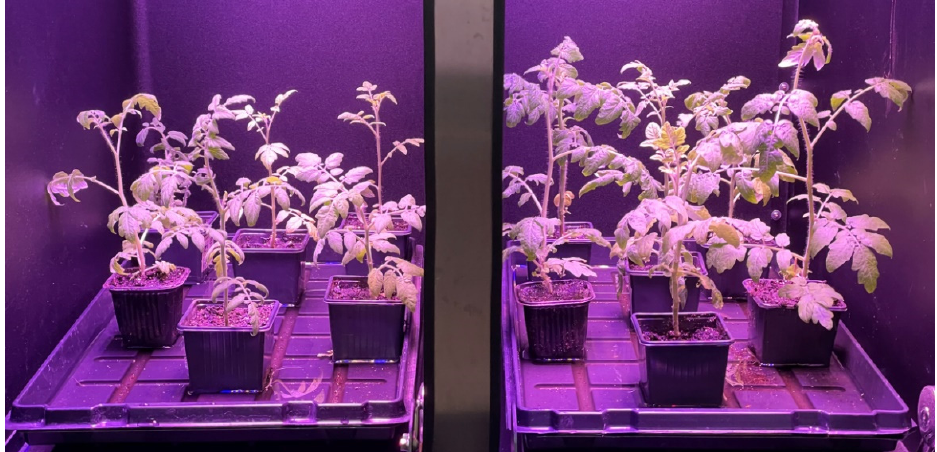
Figure 2. Photo of tomatoes grown under glasses coated with fluoroplate polymer without ( left ) or with ( right ) photoconversion nanoparticles.